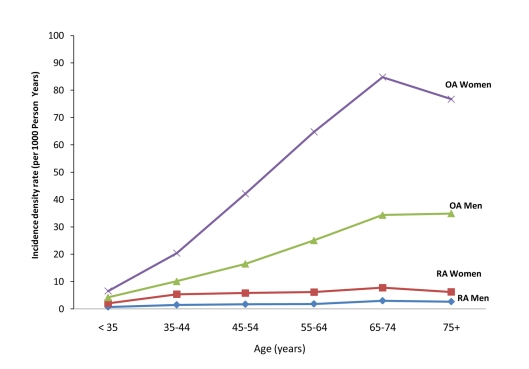
Incidence density rate (per 1,000 person-years) of RA and OA in study cohort, by age and sex, 1998–2006.